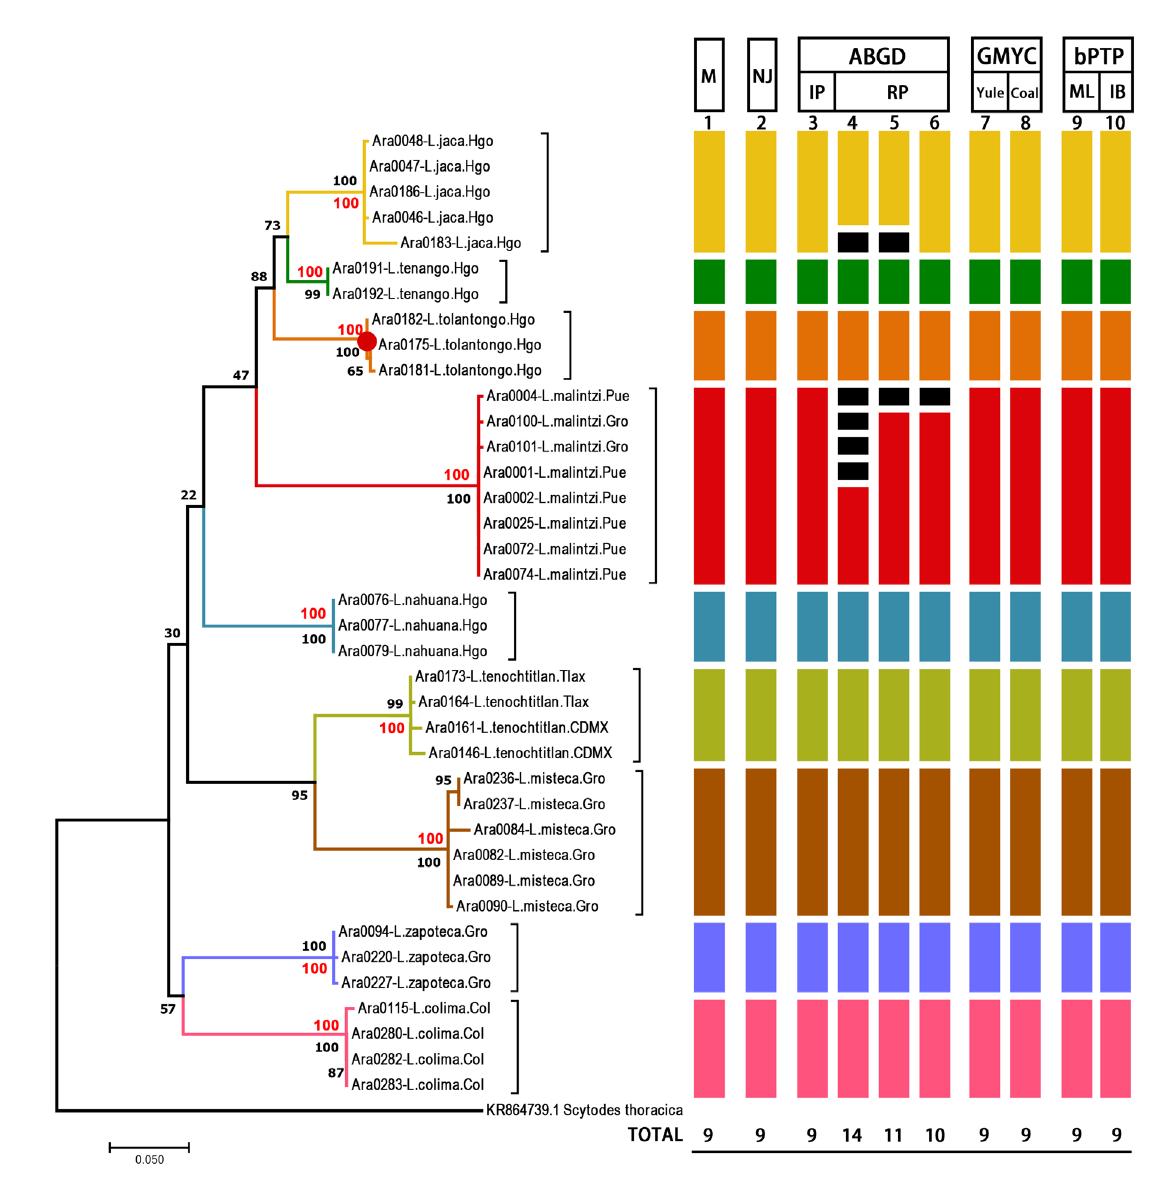
Fig. 54. Maximum likelihood tree inferred from CO1 gene of species of Loxosceles Heineken & Lowe, 1832 from Mexico. Colors of branches and bars indicate different species. Numbers above bars represent the delimitation methods: 1 = morphology (M); 2 = neighbor joining (NJ); 3 = ABGD with initial partitions (IP); 4–6 = ABGD with recursive partitions (RP); 7 = GMYC yule analysis; 8 = GMYC coalescent analysis; 9 = bPTP with ML; 10 = bPTP with IB. Numbers below bars represent species recovered for each delimitation method. Red numbers on branches correspond to Bayesian posterior probabilities, black numbers are bootstrap support values from the ML